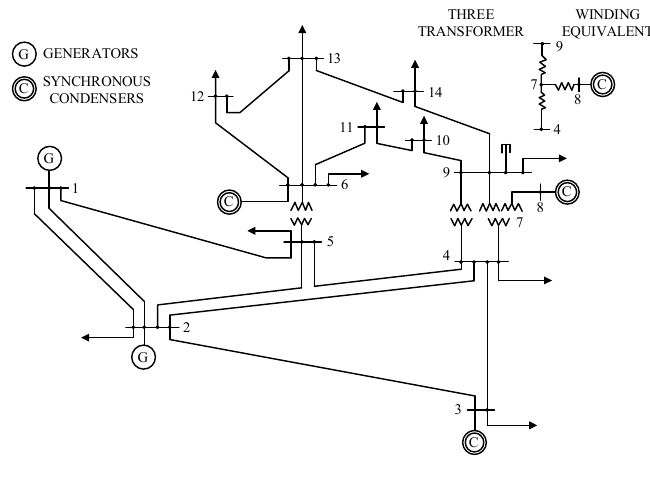
Figure 3. IEEE 14 bus system.